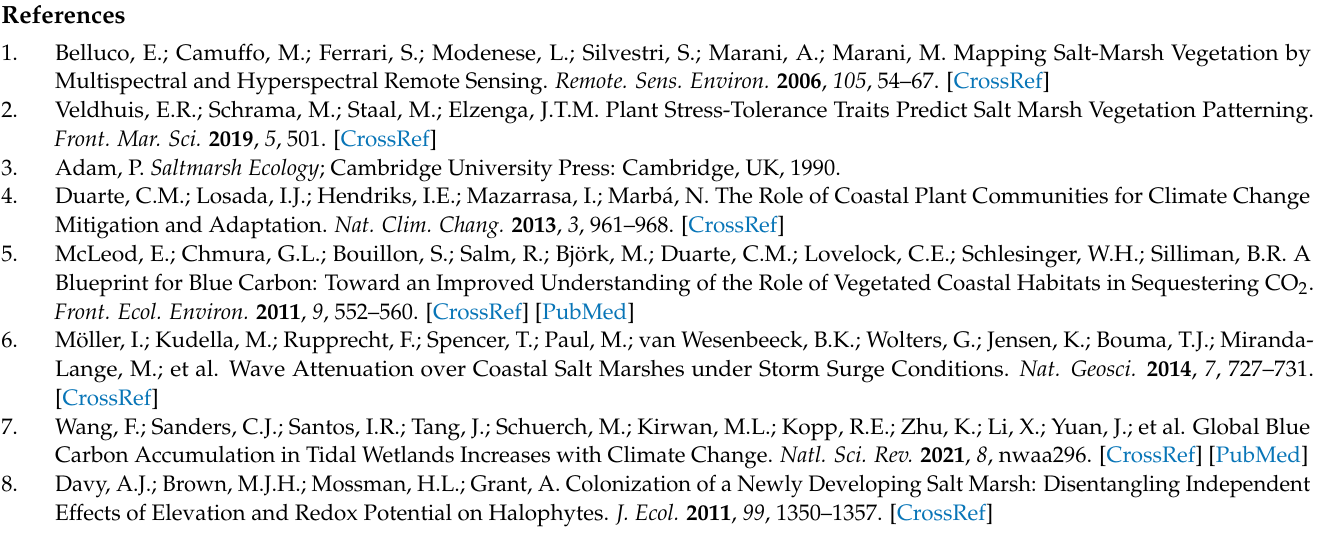
Figure A5. Distribution of the plant species present in the C á diz Bay with elevation. The elevation refers to LAT.